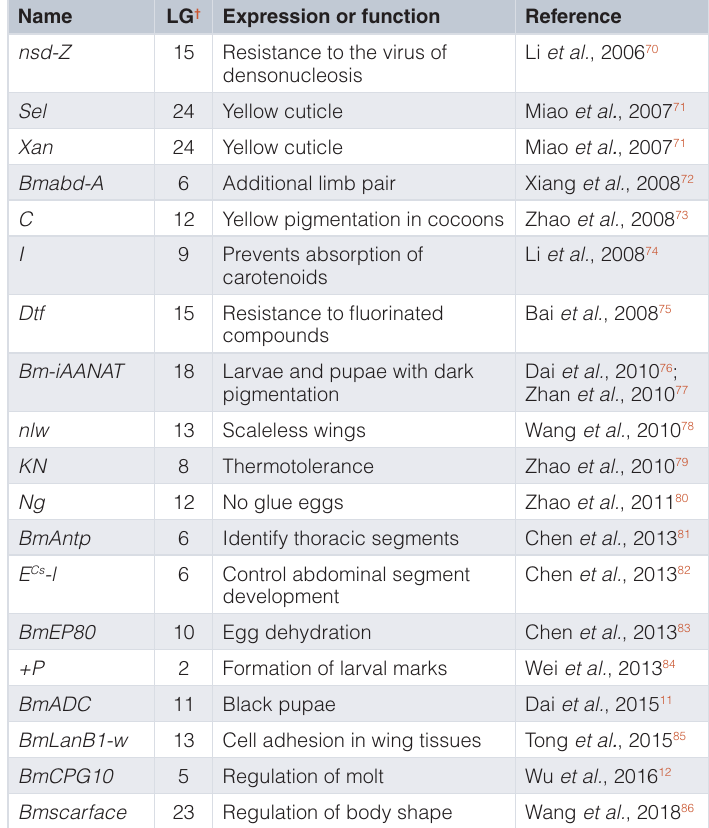
Table 3. Genes mapped using microsatellites in B. mori